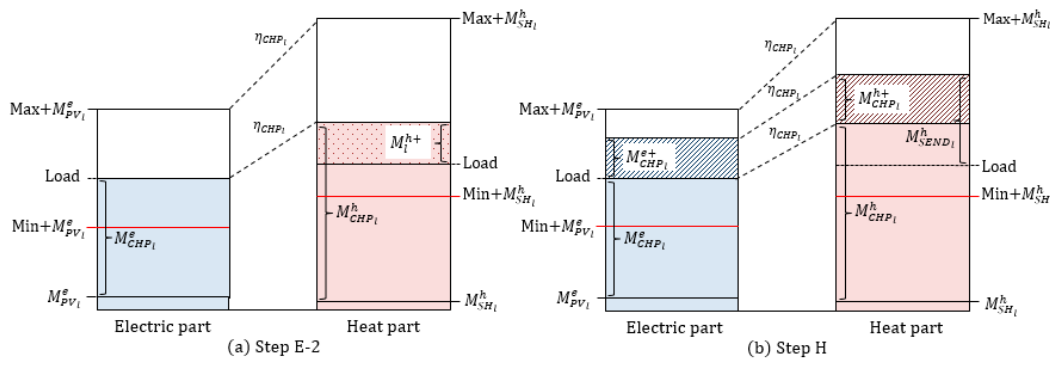
ř L p t q ą 0. Figure B1. Example ‐ 1 when ∑ M h l “ 1 CHP ` l